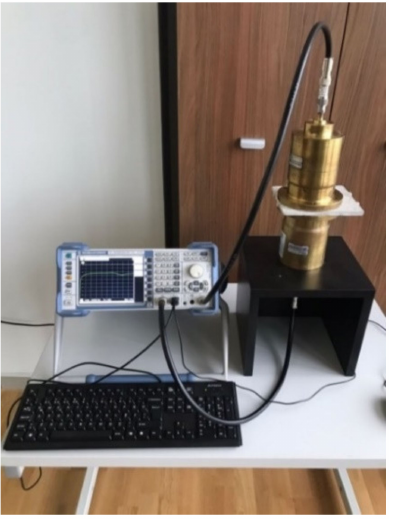
Figure 5. EM measurement system.